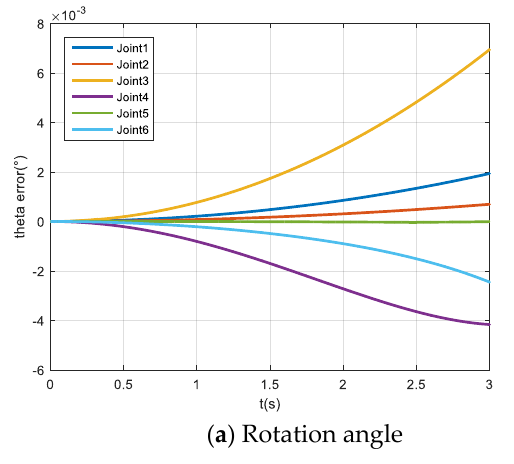
Figure 9. Deviation vs. time graph.